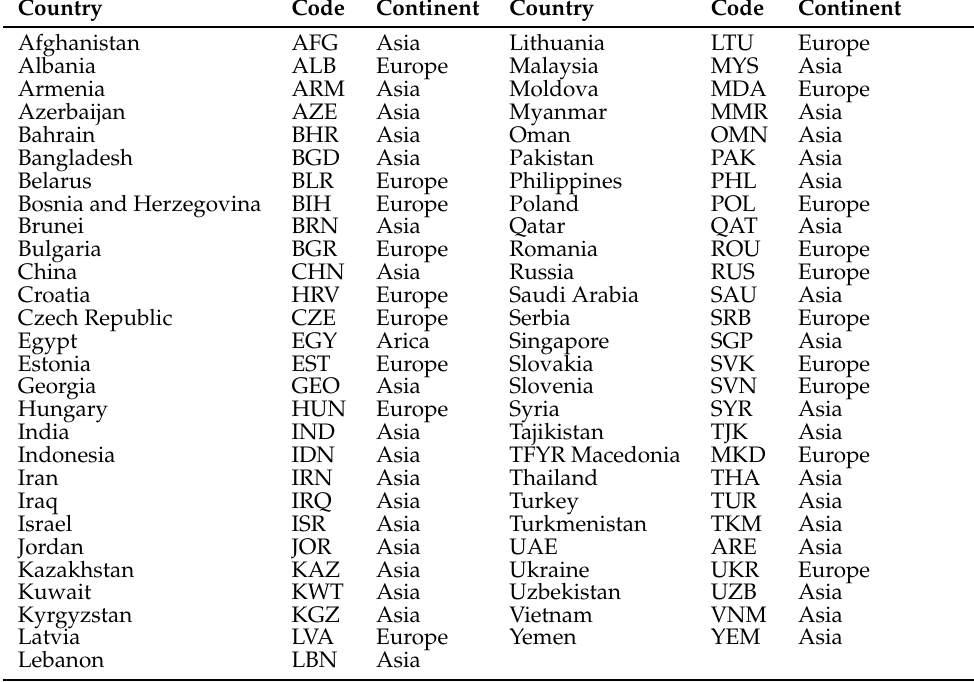
Table A2. Countries, codes, and